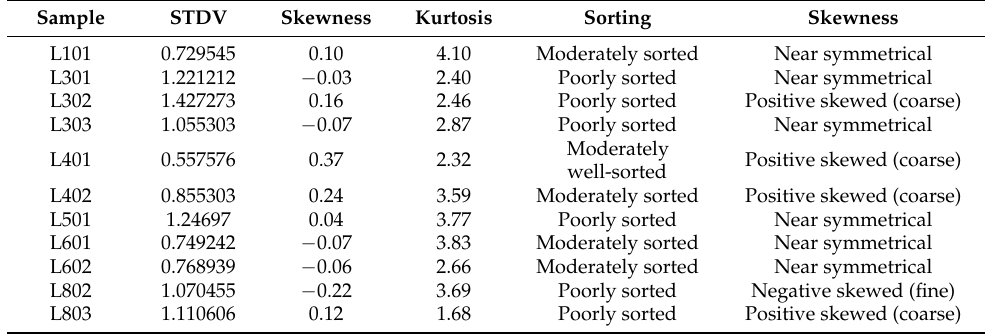
Table 4. Folk & Ward grain size statistical parameters measured from samples frequency curves